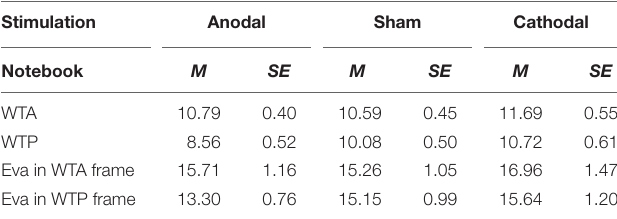
TABLE 2 | Means and standard errors of the data for the notebook in Experiment 1. Stimulation Anodal